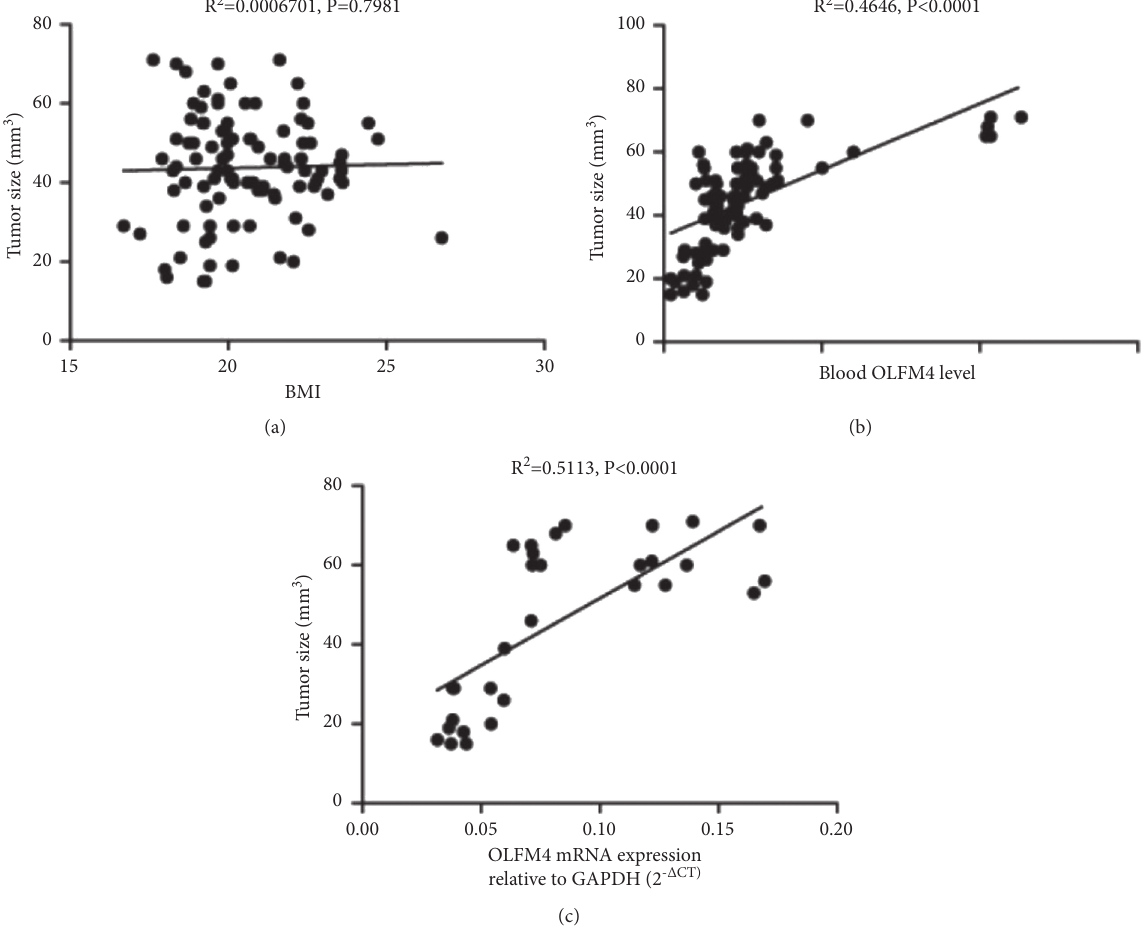
Figure 4: Correlation of OLFM4 to tumor size. (a) Correlation analysis about BMI to tumor size; (b) correlation analysis about OLFM4 blood level to tumor size; and (c) correlation analysis about mRNA expression of OLFM4 in HCC tissue to tumor size.